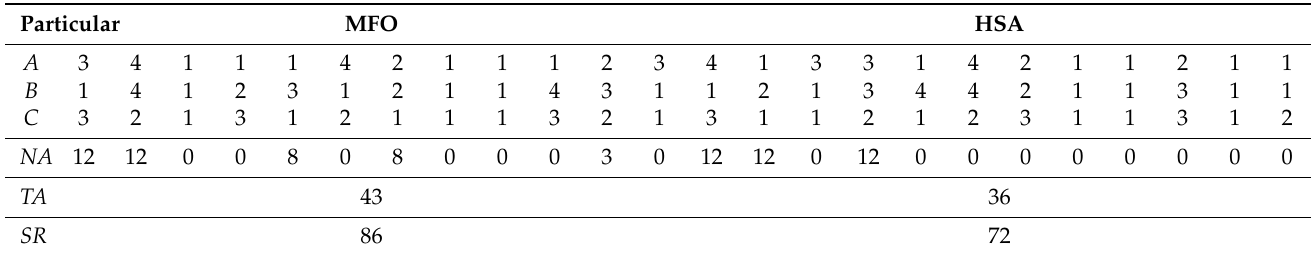
Table 17. Optimal combinations of